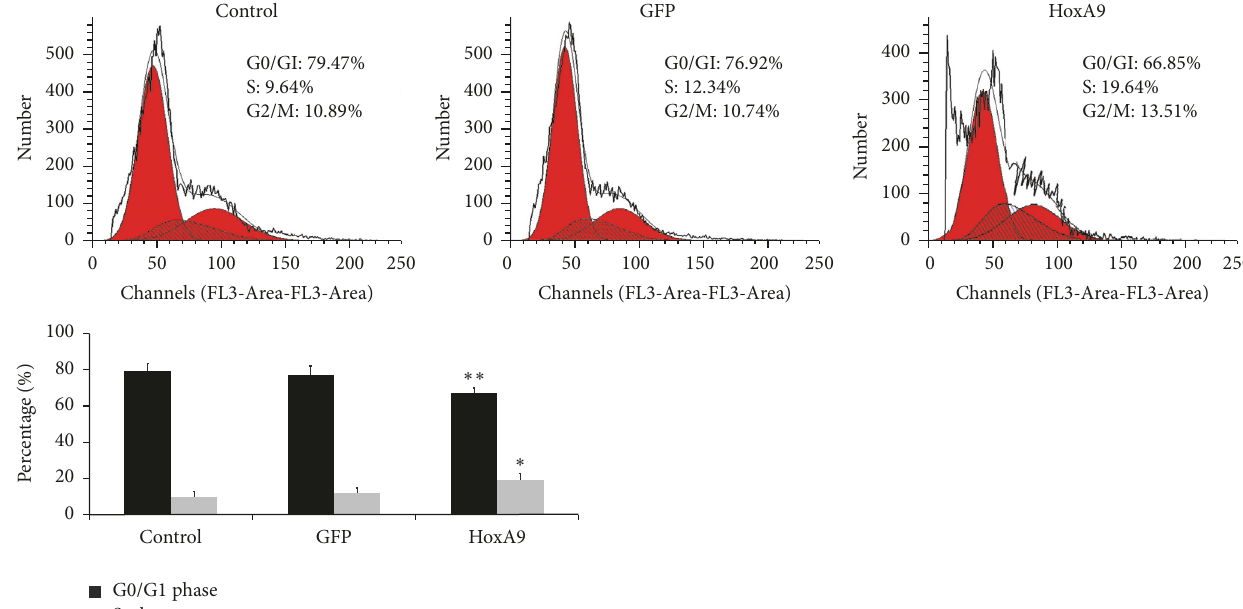
Figure 5: Proliferation of MSCs was determined by flow cytometry ( 𝑛 = 4 ). The results showed that the ratio of G0/G1 deceased, while the ratio of S phase cells was significantly increased in the pLenO-HoxA9 group. ∗ 𝑃 < 0.05 , ∗∗ 𝑃 < 0.01 versus control or GFP.